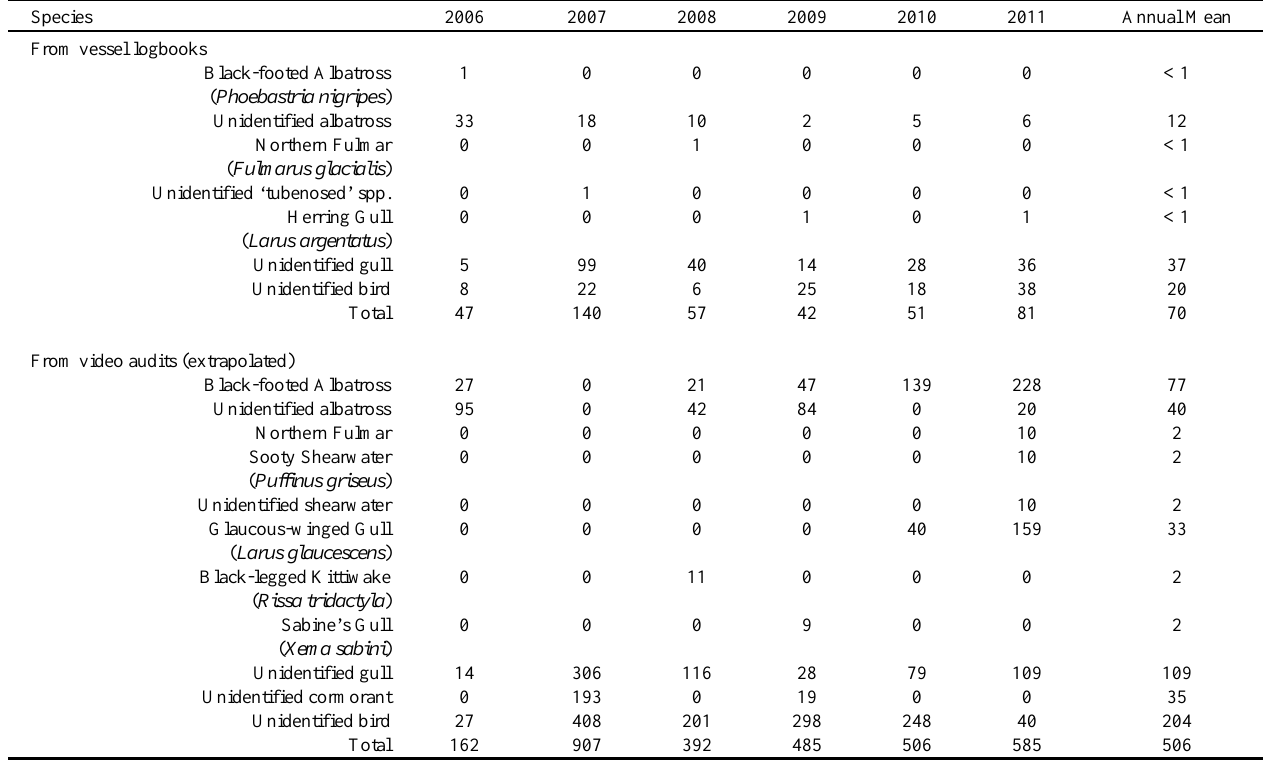
Table 3 . Reported bycatch from vessel logbooks for all commercial hook and line groundfish longline fisheries in British Columbia (2006-2011) and extrapolated bycatch estimates based upon numbers of birds detected during audits of approximately 10% of the total number of sets fished. Note: the extrapolated values (for 2010 and 2011) were derived using the average percent of sets audited in 2008 and